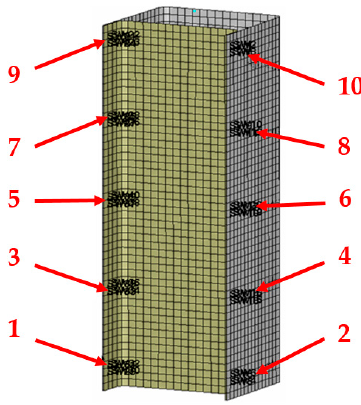
Appl. Sci. 2023 , 13 , 1686 19 of 28